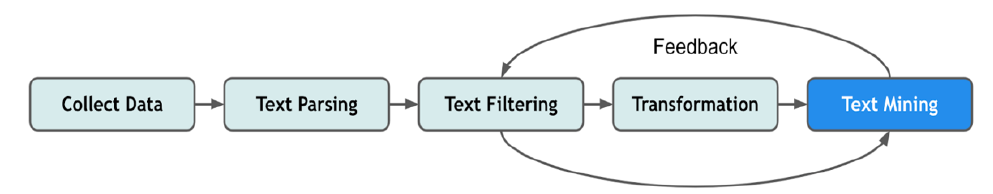
Figure 13. Typical text mining process.